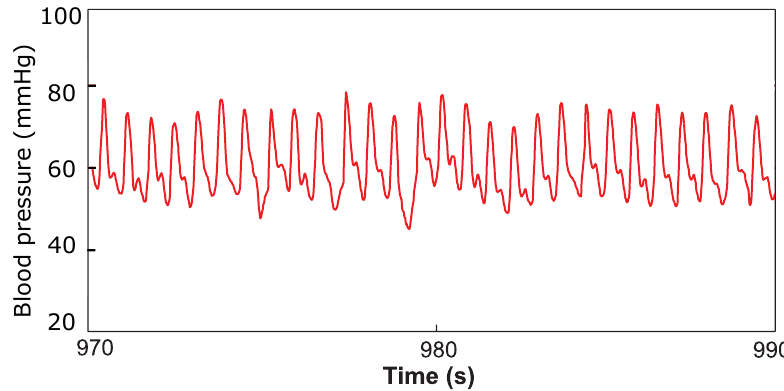
Figure 14. Twenty-second window of the arterial pressure waveform acquired during the in vivo